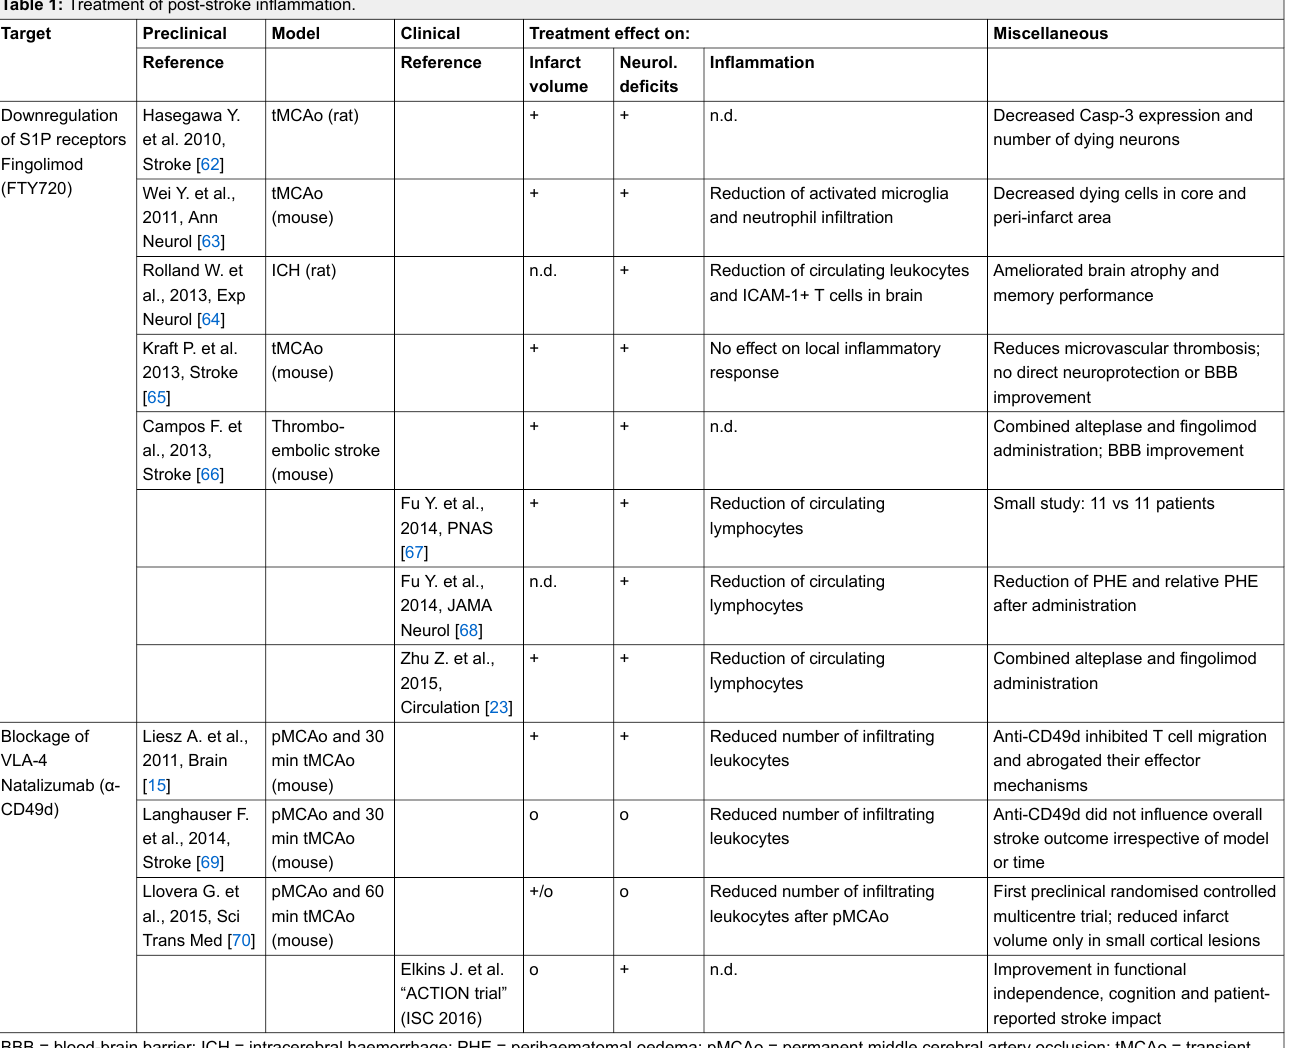
Table 1: Treatment of post-stroke inflammation.